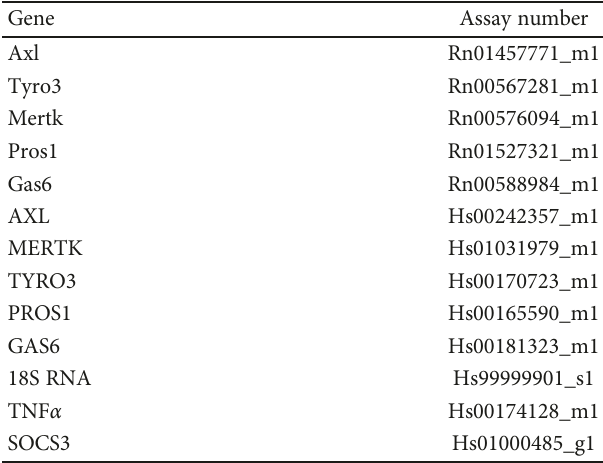
Table 2: TaqMan Gene Expression Assays.